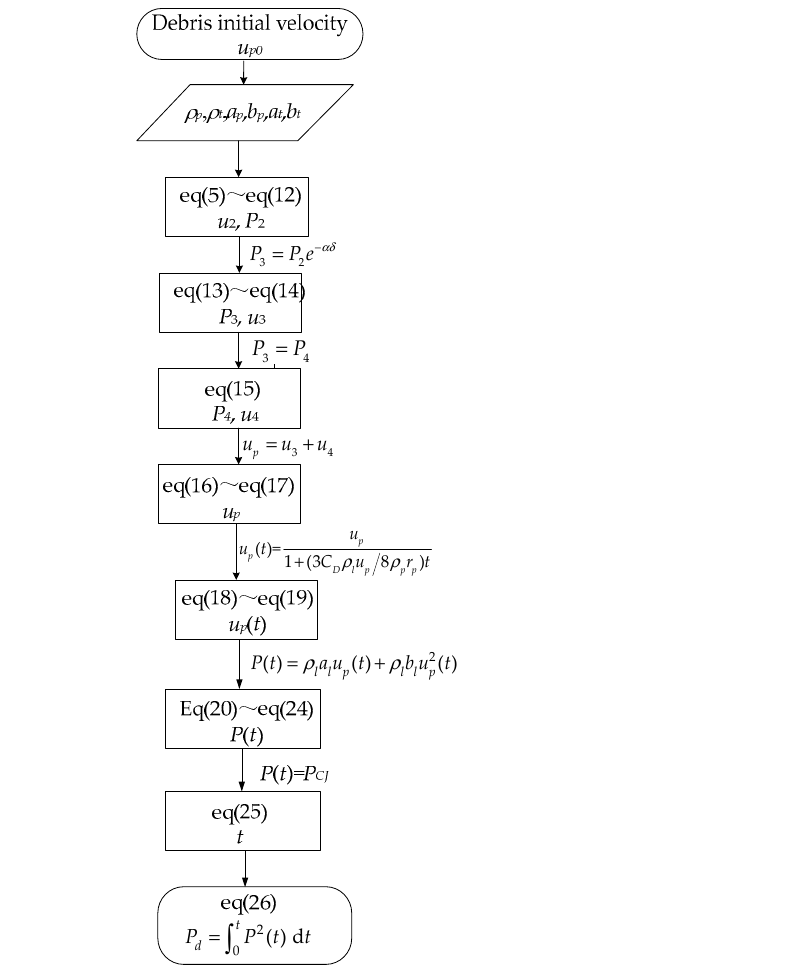
Figure 3. Flow chart of the calculation process of initiation criterion for liquid hydrazine tank.